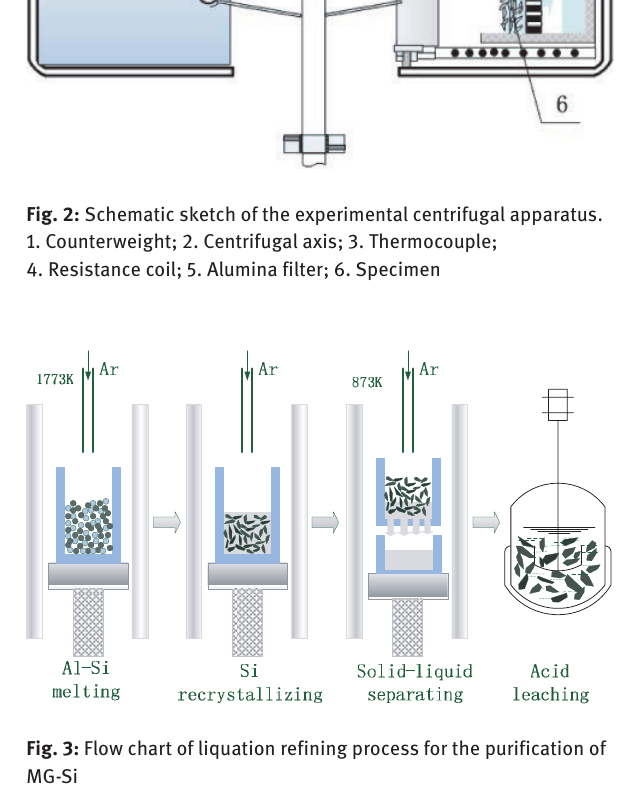
Fig. 3: Flow chart of liquation refining process for the purification of MG-Si